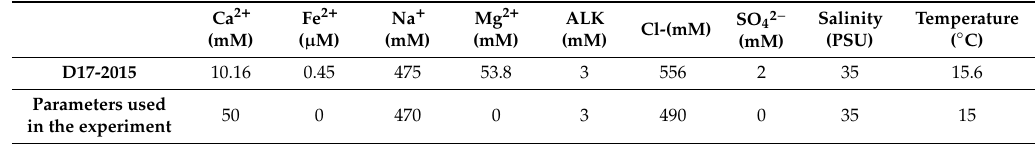
Table 1. Parameters adopted in the experiment.